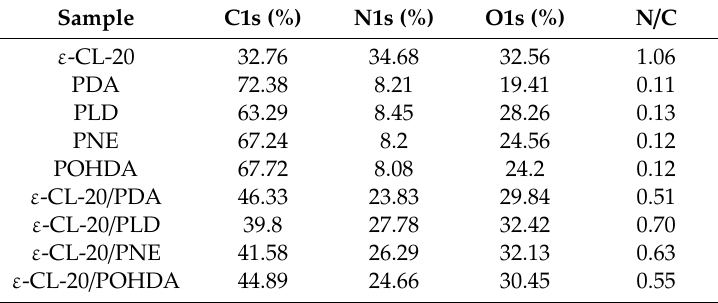
Table 2. Surface element composition of samples as evaluated by X-ray photoelectron spectroscopy (XPS).